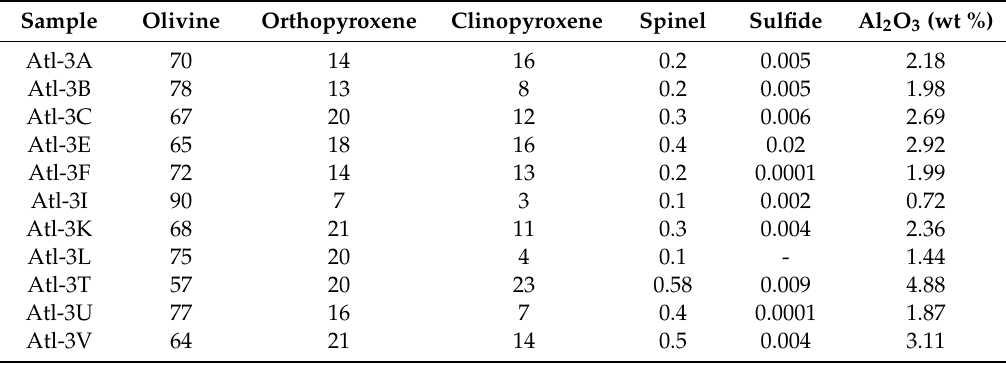
Table 1. Modal abundances of Middle Atlas xenolith silicates and sulfides (in %) and whole-rock Al 2 O 3 content (in wt %). Silicate modal abundances and Al 2 O 3 content are from Wittig et al. [20]. Sulfide modes are taken from petrographic observation. Note that samples Atl-3F, 3L, and 3U were excluded from further use in this study, since no in situ trace element analyses were